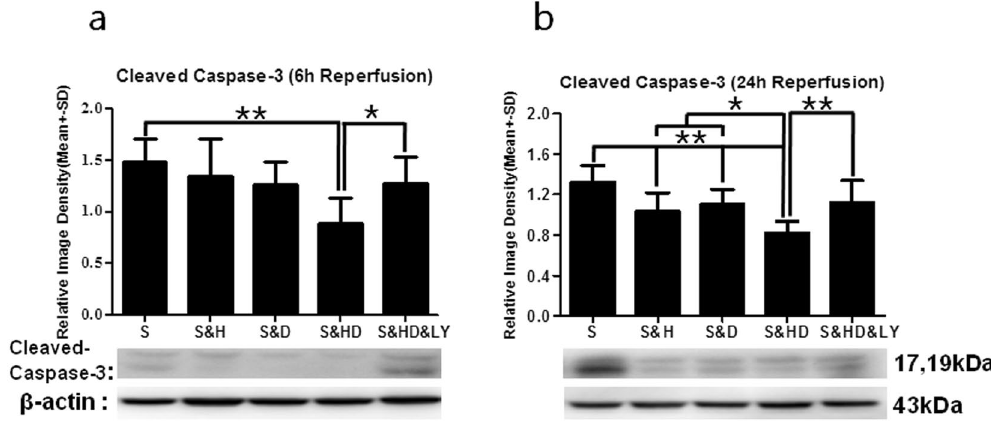
Figure 6. Reduction in cleaved Caspase-3 levels with mild hypothermia and C + P combination therapy. There was a significant increase ( ** P < 0.01) in cleaved Caspase-3 levels after ischemic stroke (S) at both ( a ) 6 h (n = 6 per group) and ( b ) 24 h (n = 6 per group) of reperfusion. Ischemia-induced increase in cleaved Caspase-3 levels was significantly reversed with combination therapy (S&HD) ( ** P < 0.01) at both 6 h ( F (4,25) = 3.432) and 24 h ( F (4,25) = 6.963) of reperfusion. Mild hypothermia (S&H) ( * P < 0.05) or C + P (S&D) ( * P < 0.05) only induced a small reduction in cleaved Caspase-3 levels at 24 h after reperfusion. PI3K / Akt inhibitor (S&HD&LY) reversed the combination therapy-induced reduction in cleaved Caspase-3 expression ( * P < 0.05 at 6 h; ** P < 0.01 at 24 h). Representative immunoblots are